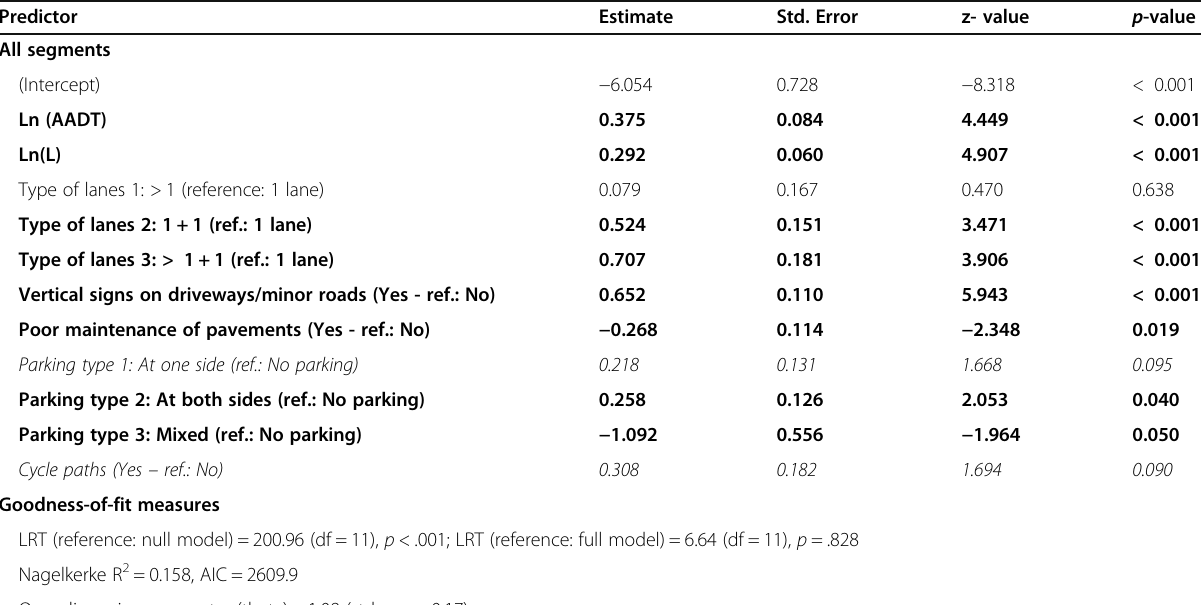
Table 2 Selected models for